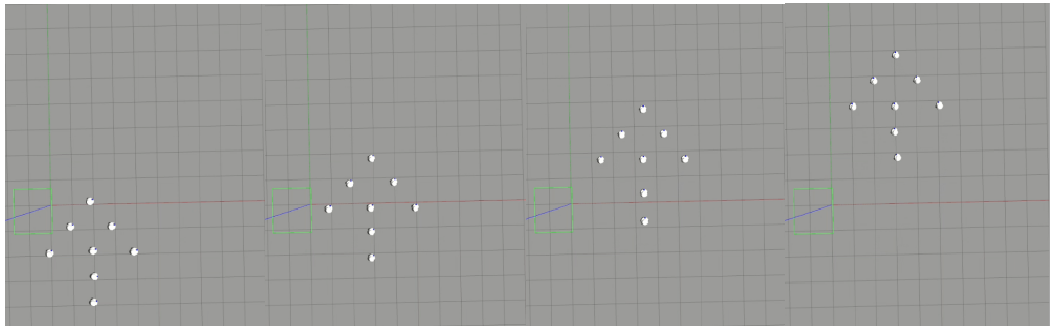
Figure 7. The arrow formation of the multi-robot navigation system.